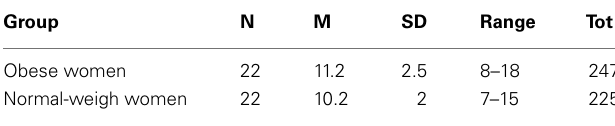
Table 1 | Productivity of the two groups: group size, mean, standard deviation, range, and total number of elicited